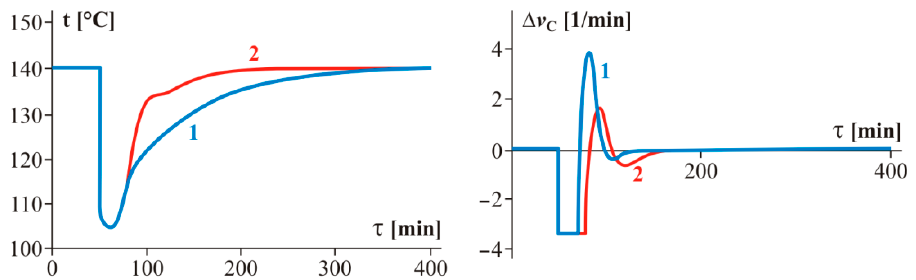
Figure 4. Transients in a closed system with an initial deviation of the state vector from static by − 20%: 1—the first variant of the algorithm (classic ADAR method); 2—second variant (cascade control system).